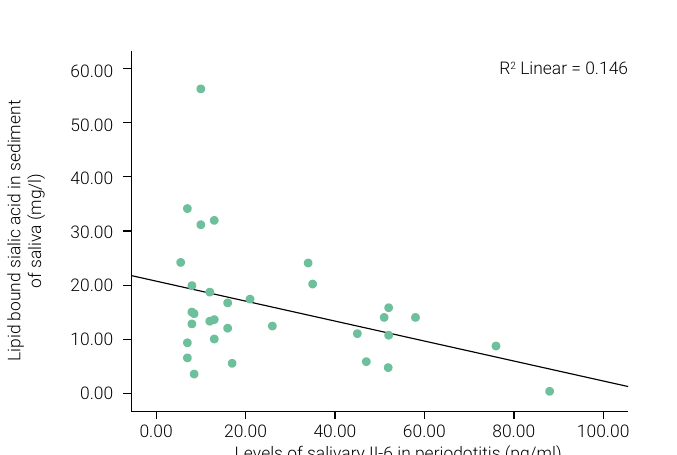
Figure 2. Inverse correlation between salivary IL-6 and lipid bound sialic acid in sediment of saliva of periodontitis